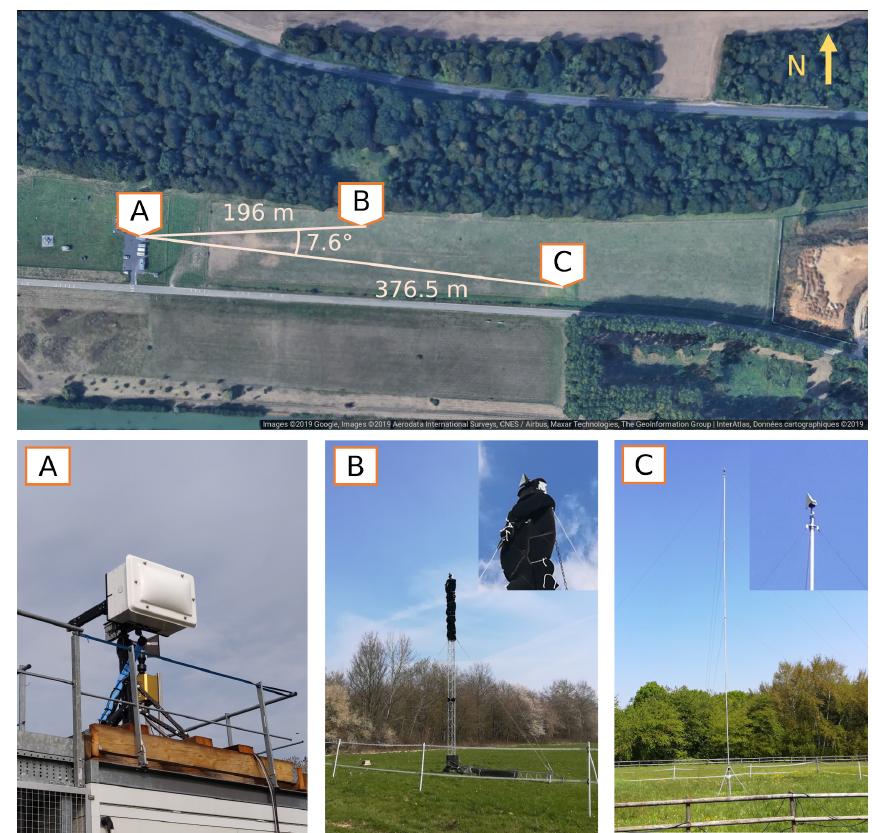
Figure 1. Experimental setup for 2018 and 2019 calibration experiments. (A) Scanning BASTA mini radar located on a reinforced platform 5m above the ground. (B) A 10m mast with a 10cm triangular trihedral target mounted on a pan-tilt motor with an angular resolution and repeatability better than 0.1 ◦ . This mast has microwave-absorbing material wrapped around it to reduce its radar cross section (RCS; clutter). The 10m mast was only installed in the 2019 calibration campaign. (C) A 20m mast with a 20cm triangular trihedral target. The target aiming is fixed relative to the mast. This mast was used in both 2018 and 2019 calibration campaigns. Angular separation between the masts is enough to sample both targets without mutual